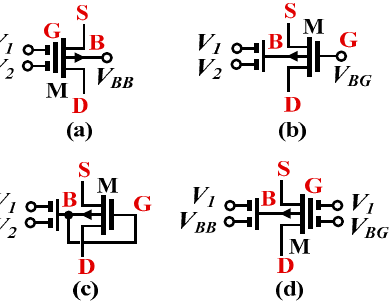
Figure 2. Symbol of the multiple-input MOS transistor: gate ( a ), bulk ( b ), DTMOS ( c ) and QFG ( d ).